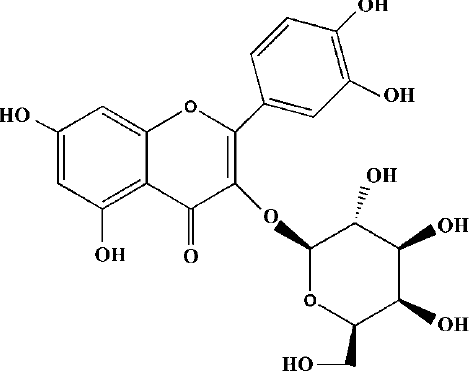
Figure 1. The structure of hyperoside .